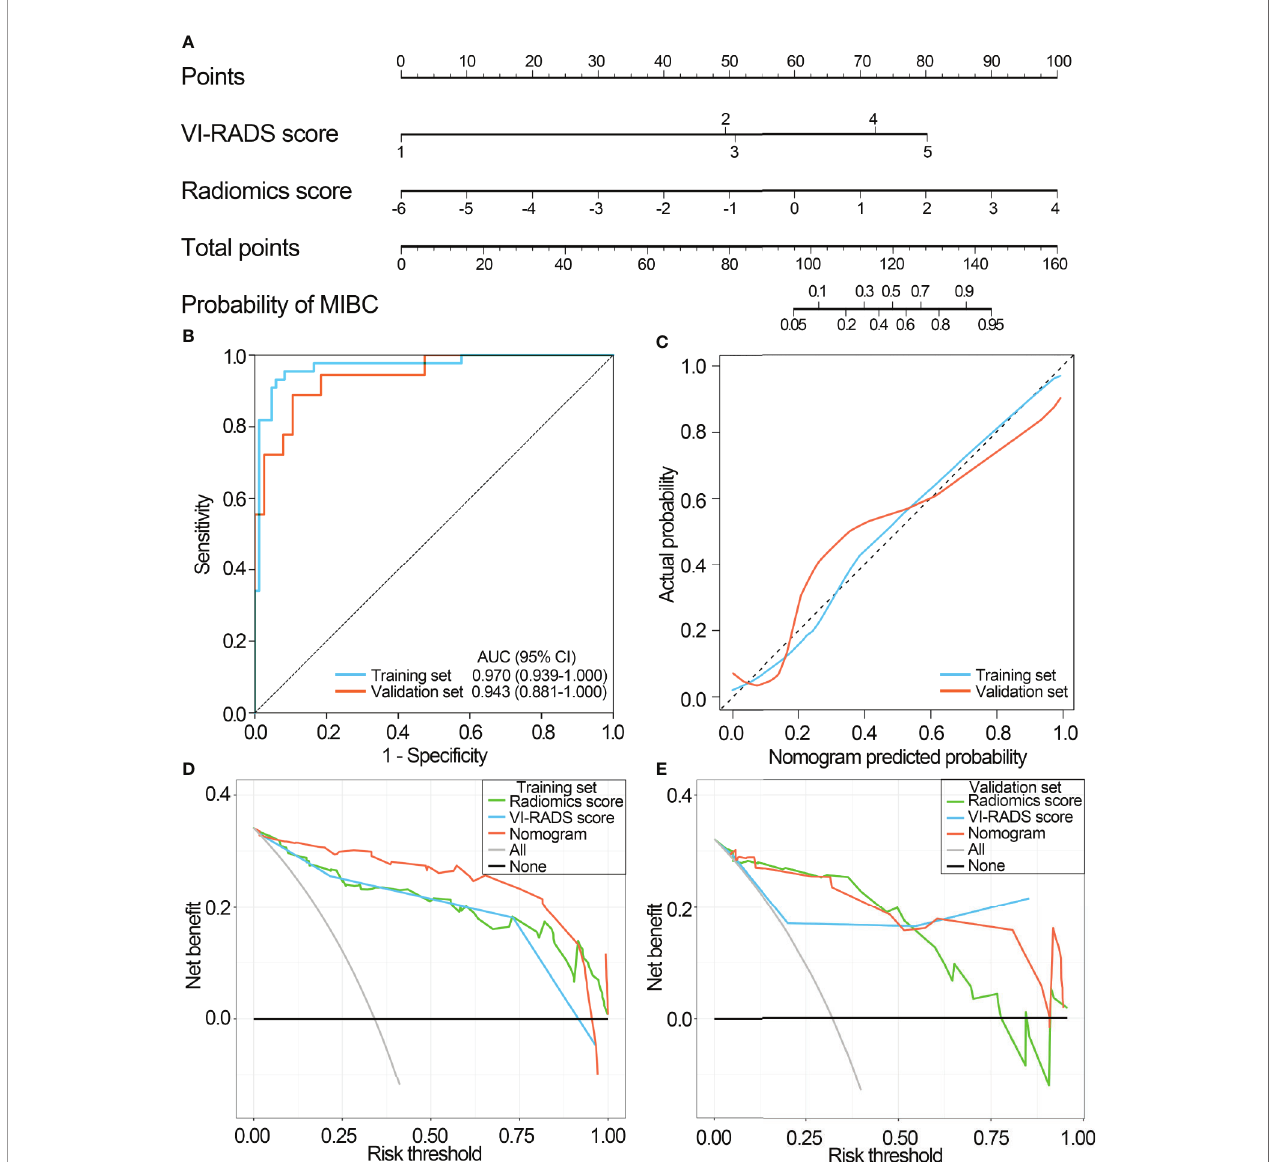
FIGURE 6 | Performance of the nomogram integrating the radiomics score with the VI-RADS score. (A) The nomogram integrating the radiomics score with the VI- RADS score was constructed to predict muscular invasiveness in patients with bladder cancer. (B) ROC curves of the nomogram in the training and validation sets. (C) Calibration curve of the nomogram in the training and validation sets. (D) DCA for radiomic signature, VI-RADS score and nomogram in the training set. (E) DCA for radiomic signature, VI-RADS score and nomogram in the validation set. VI-RADS, Vesical Imaging-Reporting and Data System; ROC, receiver operating curve; AUC, area under the ROC curve; DCA, decision curve